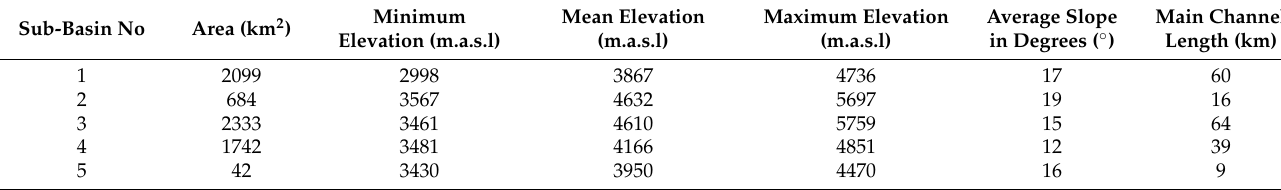
Table 1. Physiographic characteristics of sub-basins.